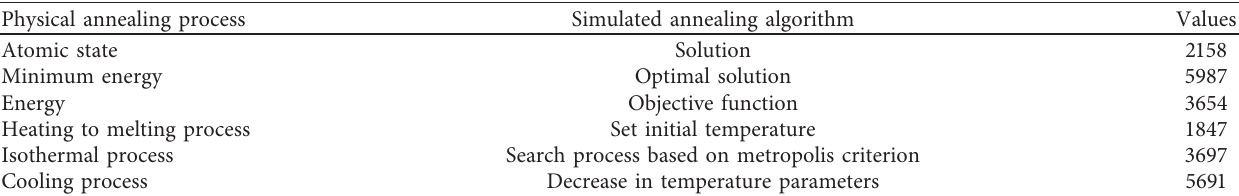
Table 1: Comparison of physical annealing process and simulated annealing